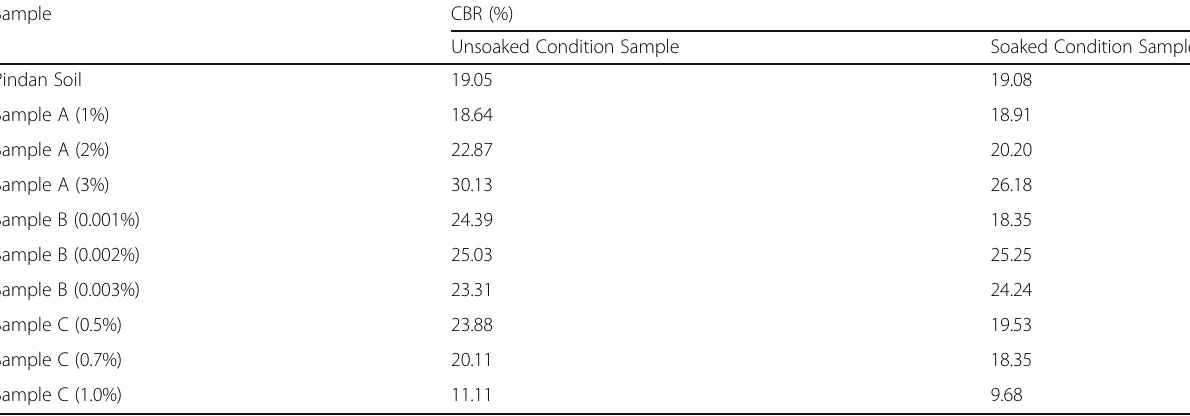
Table 7 Averages of the CBR values for saturated and unsaturated samples Sample CBR (%) Unsoaked Condition Sample Soaked Condition